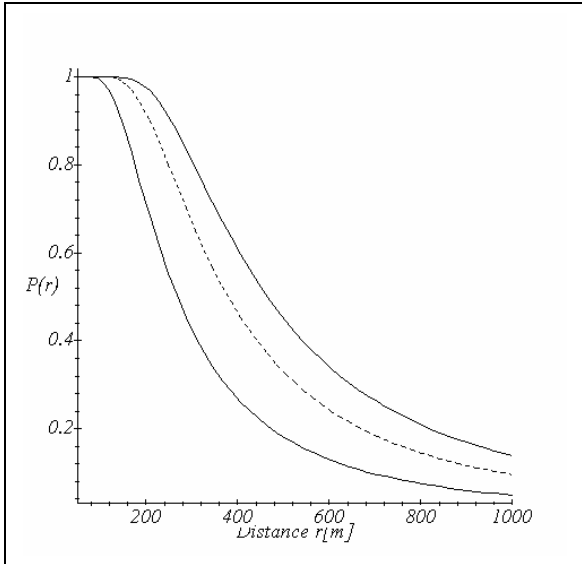
Fig 4. Dependence of probability of the detection of the enemy P ( r ) from the distance to it. Upper curve corresponds to time of observation 15 s , dotted – 10 s , lower – 5 s